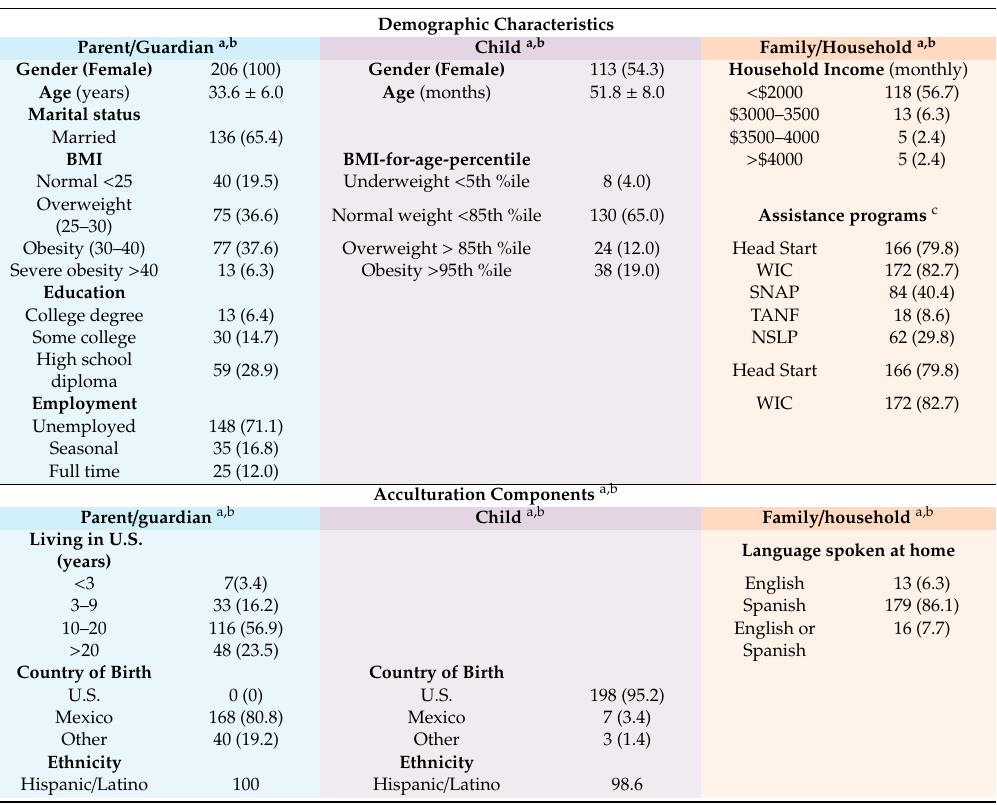
Table 2. Descriptive statistics of Niños Sanos study participants by parent, child, family and acculturation variables ( n = 206 parent / child